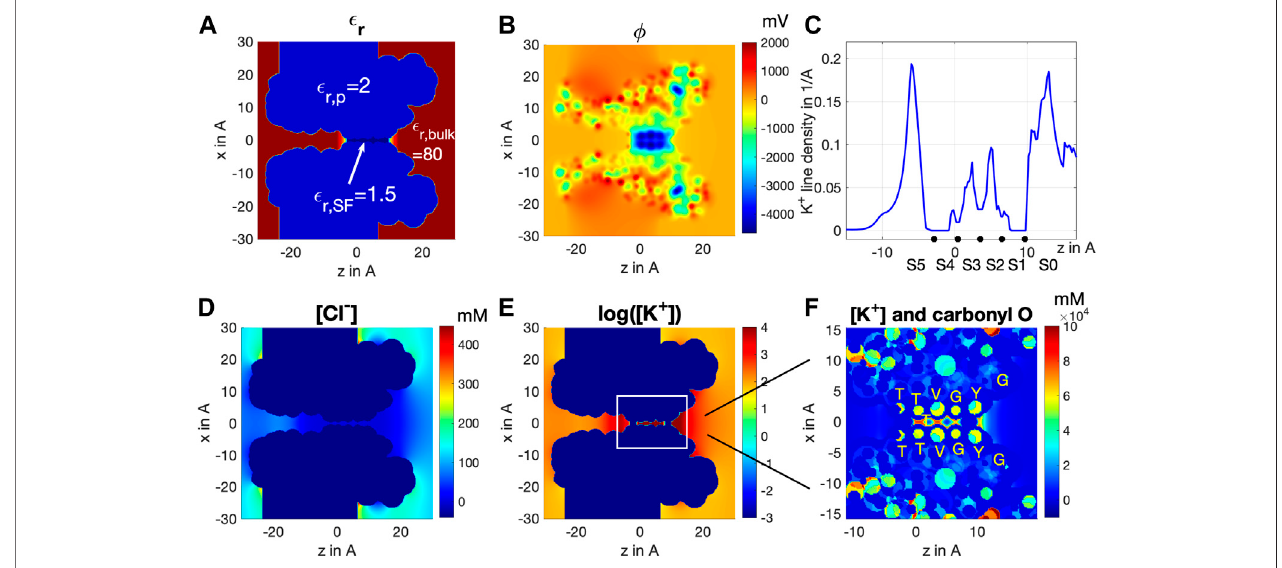
FIGURE3| Cross-section distribution of (A) dielectricconstant ε r , (B) electricpotential ϕ , (C) linedensitydistributionofK + ionsalongthecentral axis, (D) [ Cl − ] and (E) log 10 [ K + ] , at equilibrium ( V (cid:1) 0). (F) close-up of cross-section distribution of [ K + ] and − q around